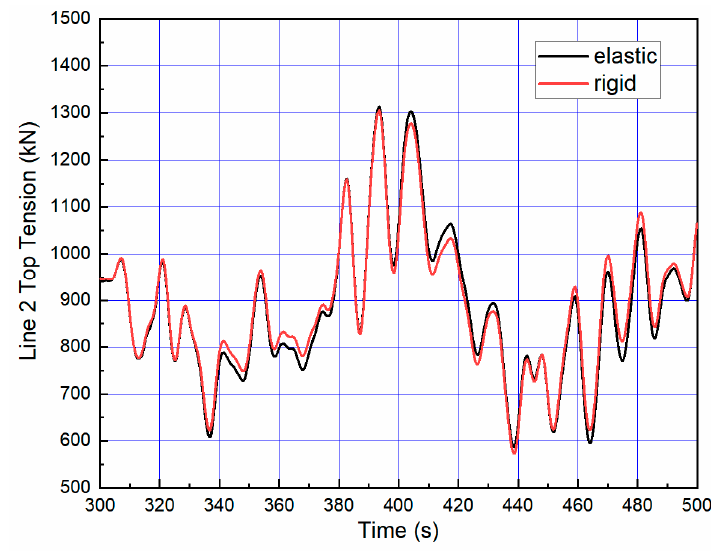
Figure 16. Comparison of mooring line tensions between elastic and rigid models for the tower and blades (taut mooring).